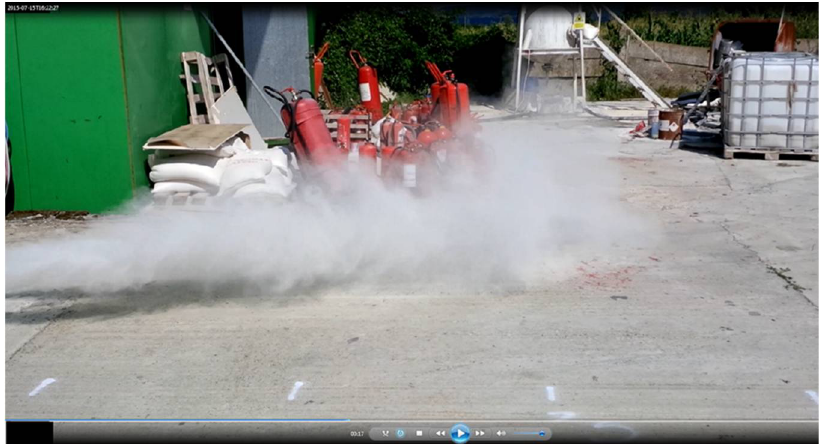
Figure 21. Extinguishing jet performance. The fire was maintained by a pile of cotton cloths soaked in liquid fuel or diesel. When the smoke became sufficient and the wind direction changed toward the robot, the smoke sensors triggered the fire extinguishing system. The system was constructed with the help of two inert gas fire extinguishers.